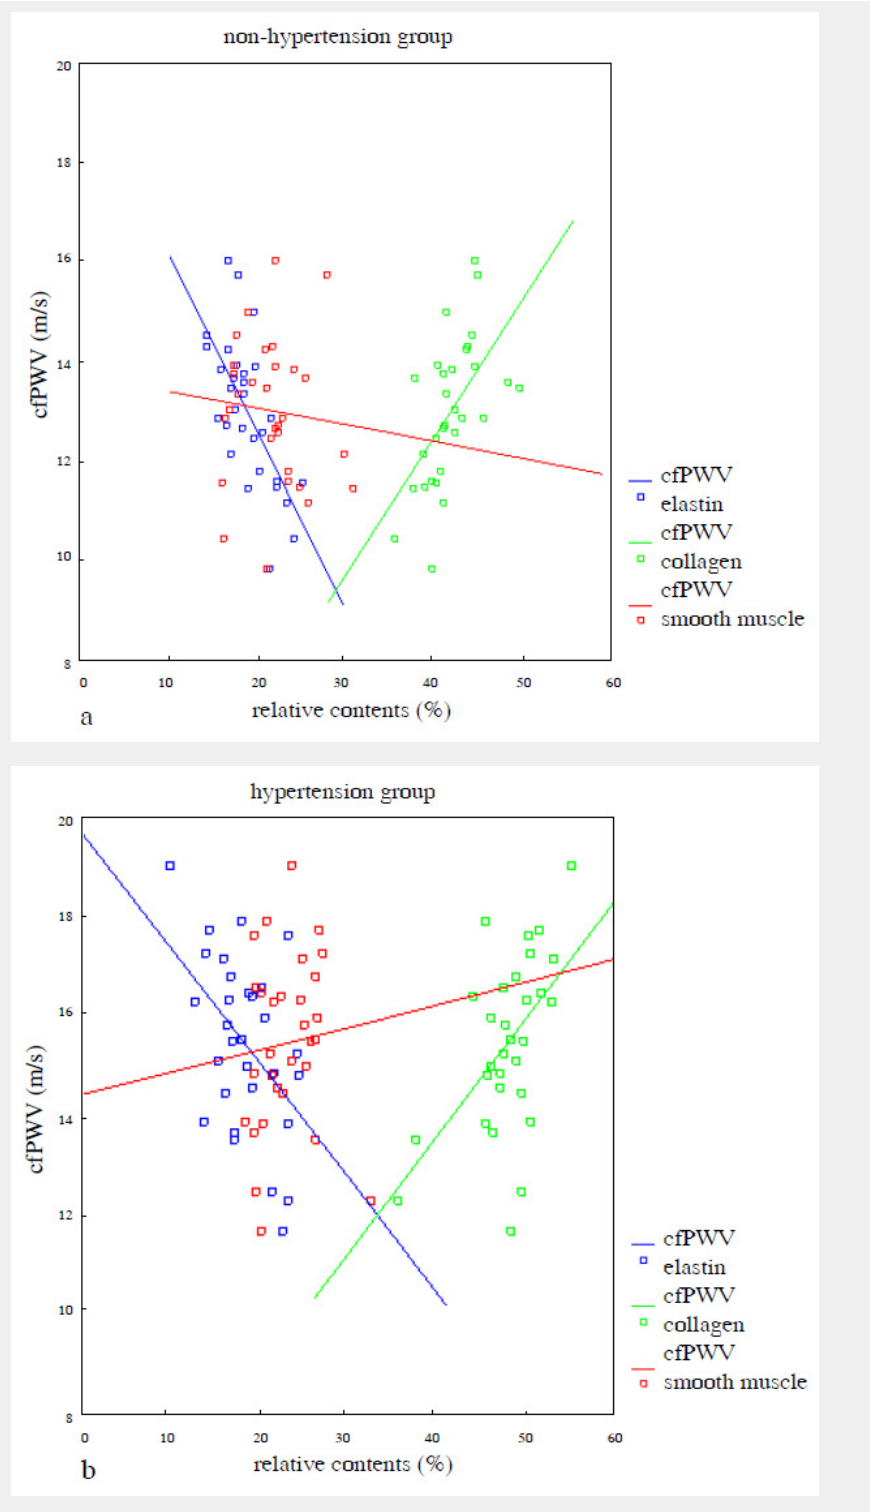
Figure 2 a) Correlation between cfPWV and relative contents of elastin (r = –0.669, 95%CI: –0.517~–0.206, P <0.01), collagen (r = 0.576, 95%CI: 0.127~0.436, P <0.01) and smooth muscle (r = ‒0.089, 95%CI: –0.181~0.113, P = 0.638) of the aortic media in the non-hypertension group; b) Correlation between cfPWV and relative contents of elastin (r = –0.475, 95%CI: –0.419~–0.069, P <0.01), collagen (r = 0.539, 95%CI: –0.098~–0.400, P <0.01) and smooth muscle (r = 0.086, 95%CI: –0.167~0.263, P = 0.652) of the aortic media in the hypertension group (simple linear regression was used in fig.